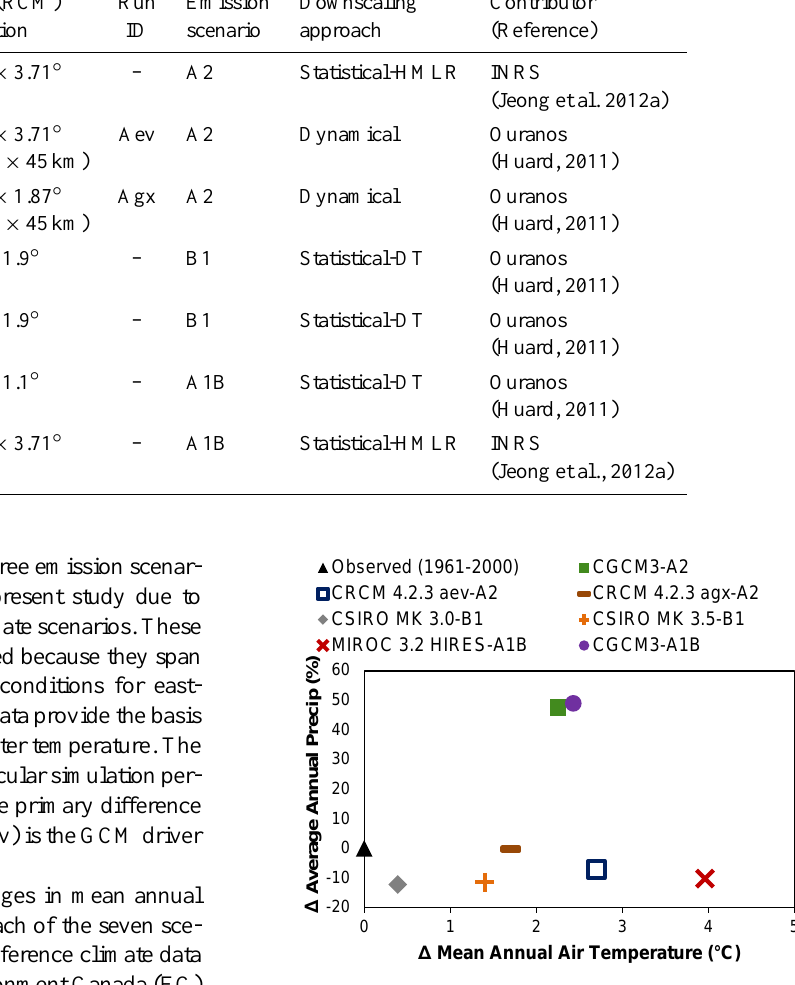
Fig. 3. Projected changes in average annual precipitation vs. pro- jected changes in mean annual AT for east-central New Brunswick. The climate data from the observed period (1961–2000) were cho- sen for a baseline for which to compare the future period (2046– 2065) period simulations. The 1961–2000 observed data series and each projected climate series (2046–2065) have their own distinct set of statistics (e.g. annual mean and standard